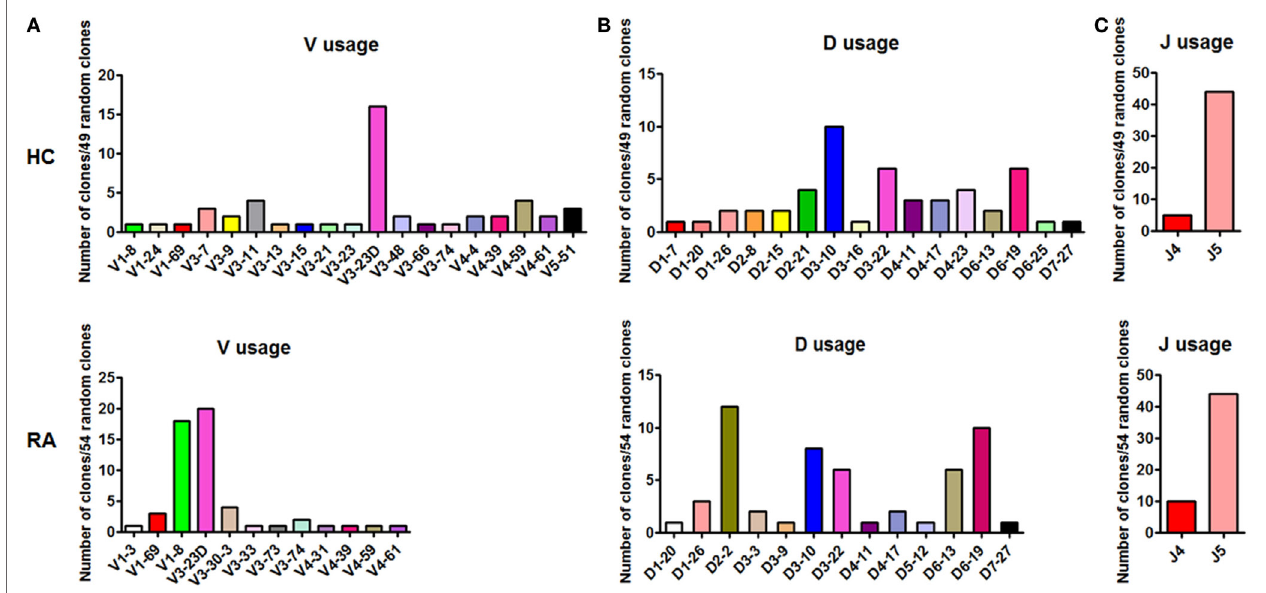
FigUre 4 | BCR repertoire analysis of CD27 + IgD + B cells both in healthy individuals and rheumatoid arthritis (RA) patients. CD27 + IgD + B cells from both healthy individuals ( n = 11) and active RA patients (DAS28 > 5.1, n = 10) were sorted by flow cytometry and subjected to the PCR amplification of the variable region of the Ig μ chain using the universal primers. Then the PCR products were purified and cloned into the T-EASY vector for the following single clone sequencing (~50 random clones). The VDJ rearrangements were further analyzed using the Ig blast database in the NCBI website. (a) : V usage; (B) : D usage; (c) : J